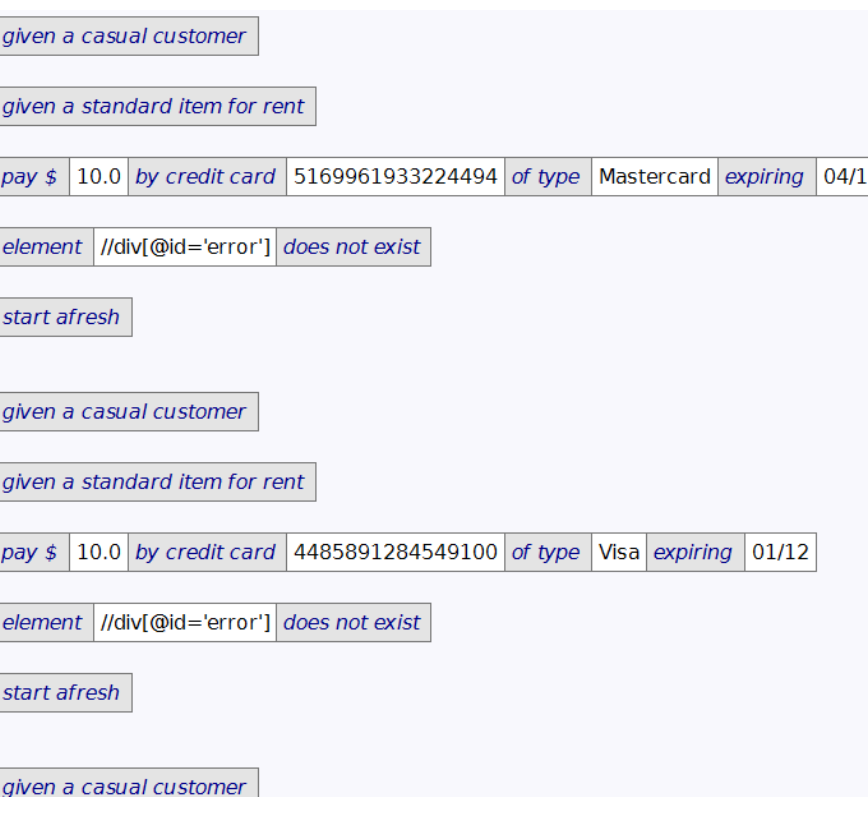
Figure 8. A multi-defined